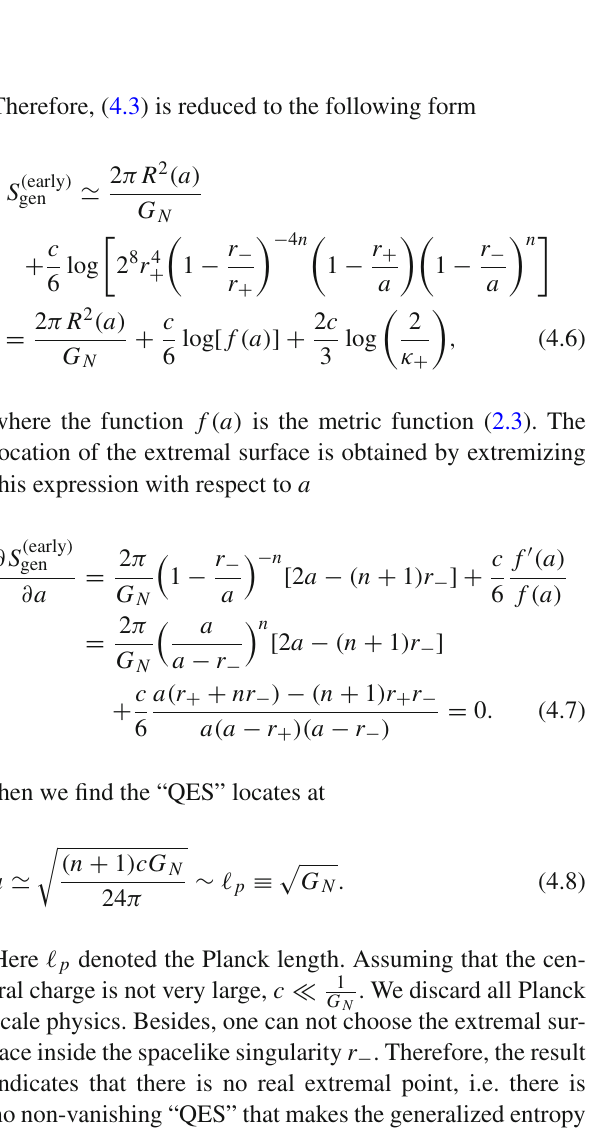
Fig. 2 Penrose diagram for GHS black holes with the island. The left for 0 ≤ n < 1, while the right for n = 1. The boundary of the island is located at a ± . The cutoff surface is denoted as b ± . Notice that the location of island where extends to outside the event